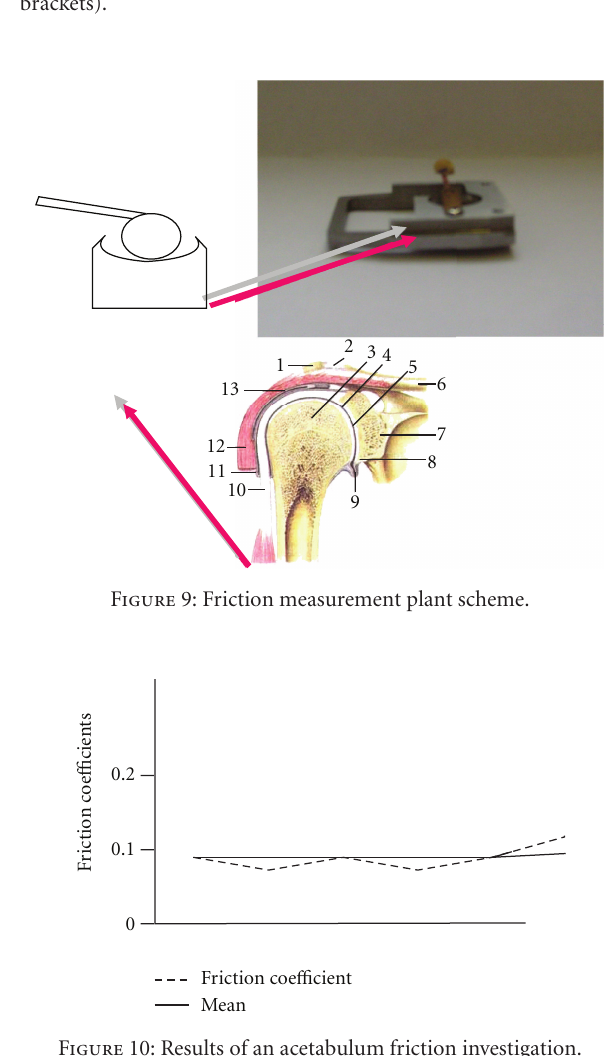
Figure 8: Dependences for friction coe ffi cient of the bulk cartilage from the applied loads (curves are numbered in order of recovery; time passed from the beginning of the experiment is pointed in brackets).